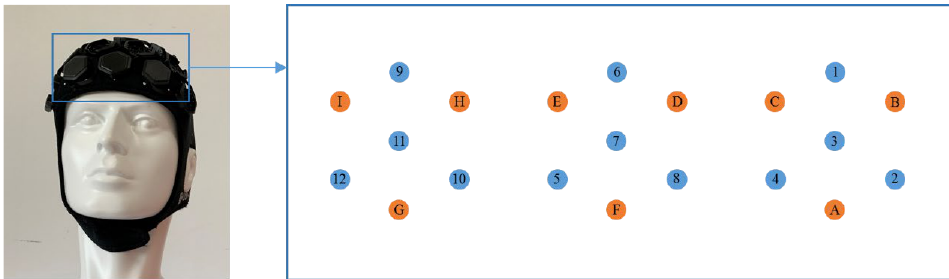
Figure 2. The position of the near-infrared light source and detector.